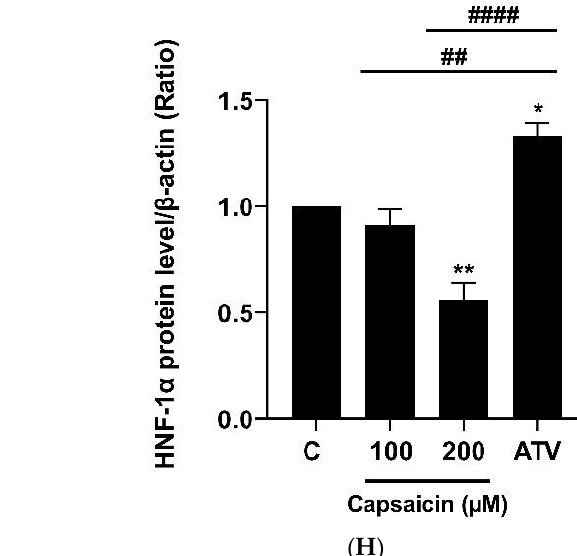
Figure 3. Effects of allicin (100, 200 µM) and capsaicin (100, 200 µM) on LDLR ( A , B ), PCSK9 ( C , D ), SREBP2 ( E , F ), and HNF1α ( G , H ) protein expression in HepG2 cells. The protein level of LDLR was determined by Western blot analysis. A representative blot is shown. The normalized intensity of LDLR versus β -actin and all data represent the mean ± SEM of three independent experiments ( N = 3). * p < 0.05, ** p < 0.01, *** p < 0.005, and **** p < 0.001 represent significant differences compared to the vehicle-treated cells or the control group (C). # p < 0.05, ## p < 0.01, ### p < 0.005, and #### p < 0.001 represent significant differences compared to atorvastatin (ATV)-treated cells. ns: not significant.